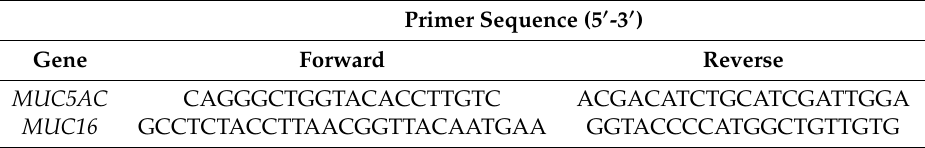
Table 2. Primers used for RT-qPCR analysis of